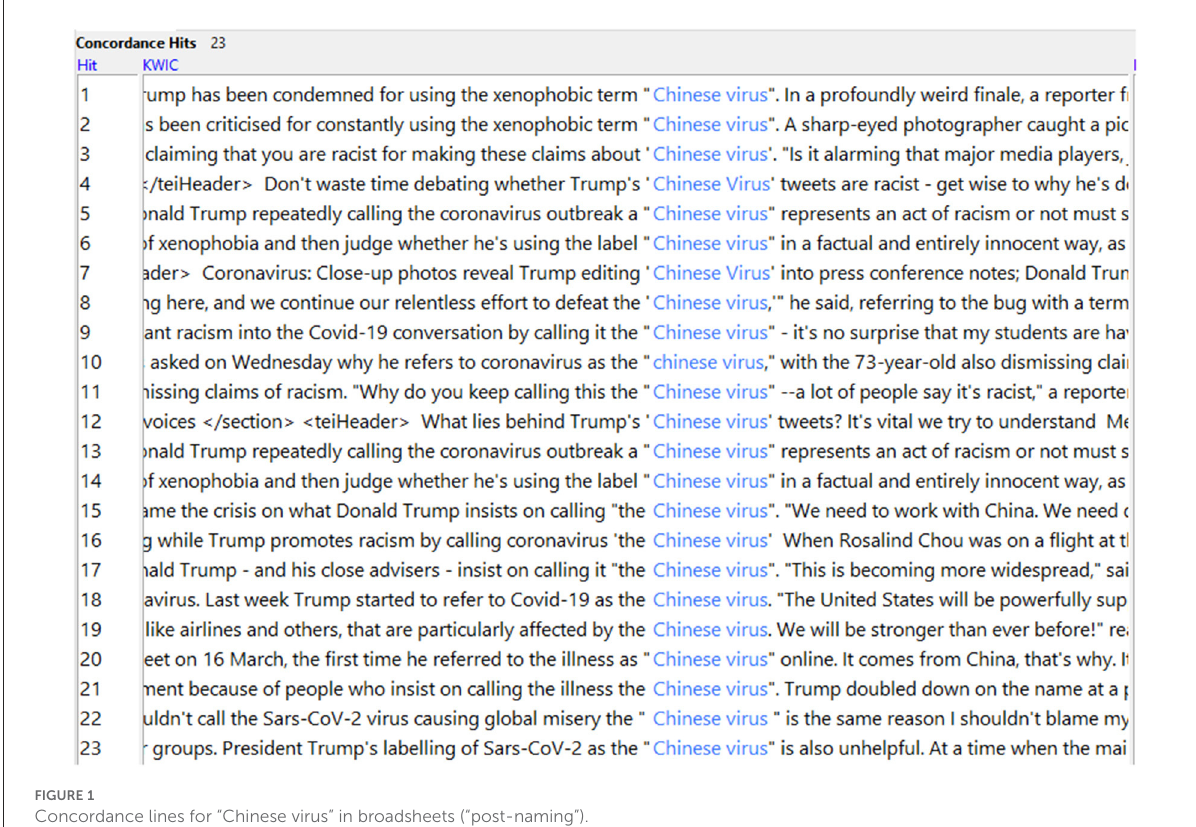
FIGURE1 Concordance lines for “Chinese virus” in broadsheets (“post-naming”).